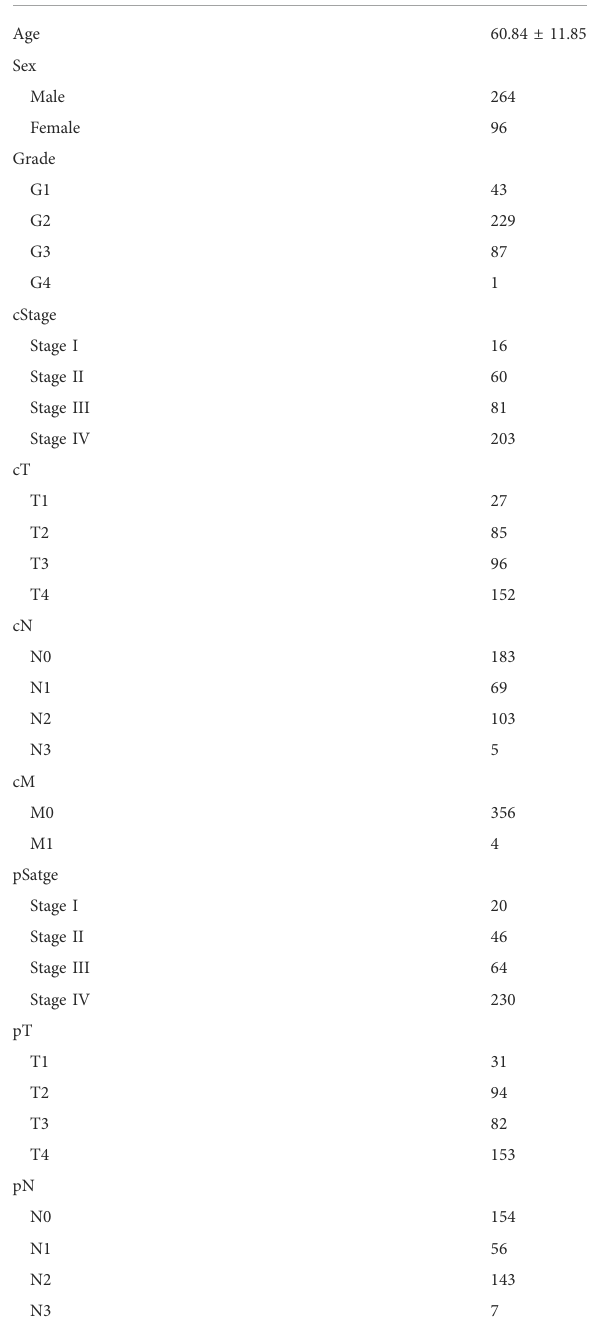
TABLE 1 Demographic characteristics of the